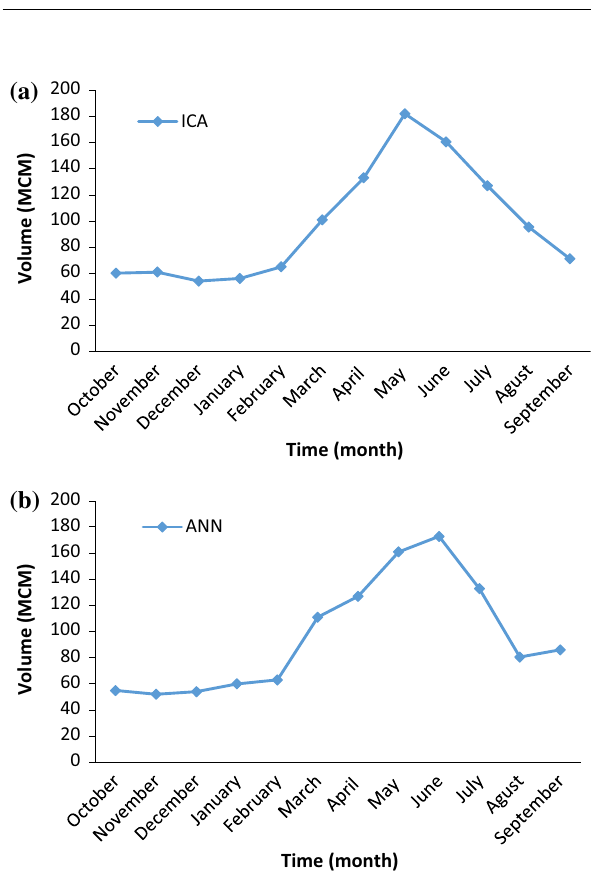
Fig. 10 Optimal monthly reservoir storage